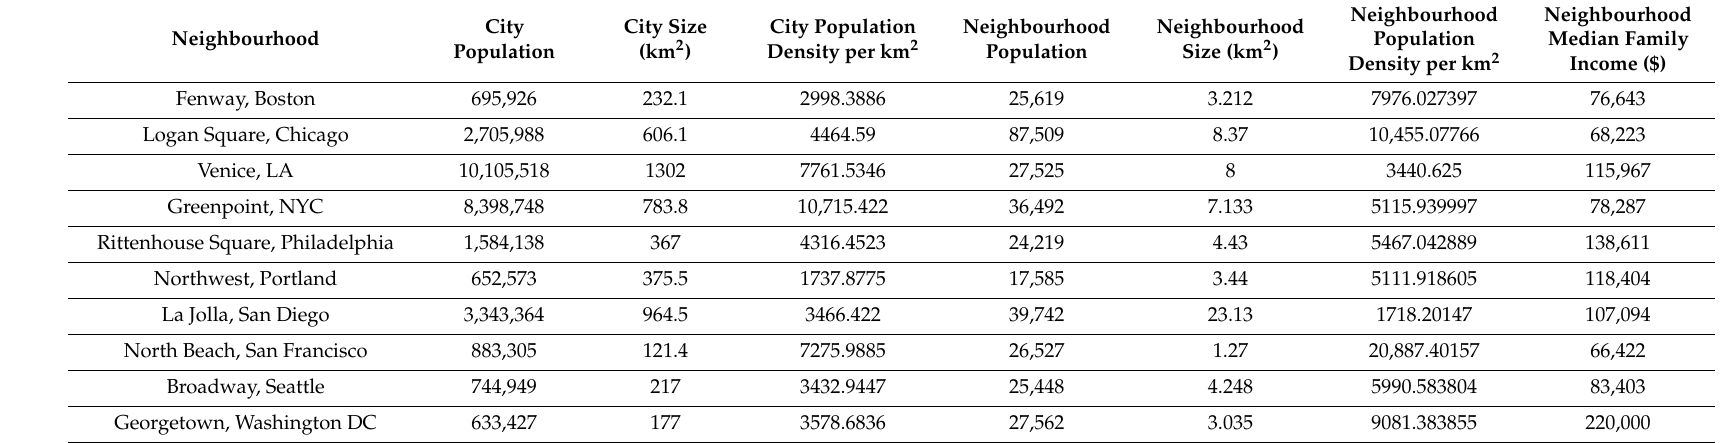
Table 1. Neighbourhood characteristics.